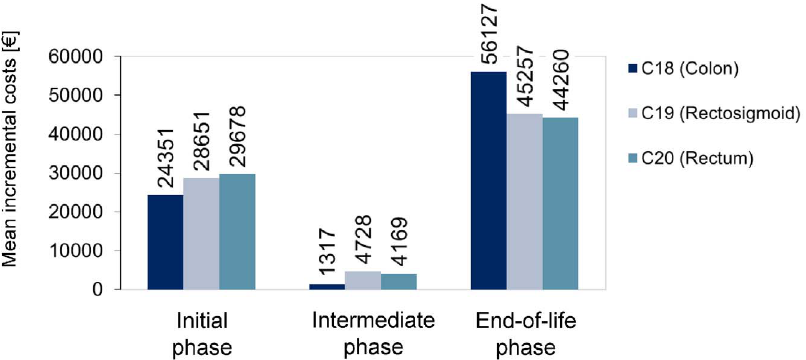
Figure 1. Mean incremental costs of CRC treatment classified into phase of care and stratified by anatomical subsite (the cost estimates are annualized as described in the methods section).